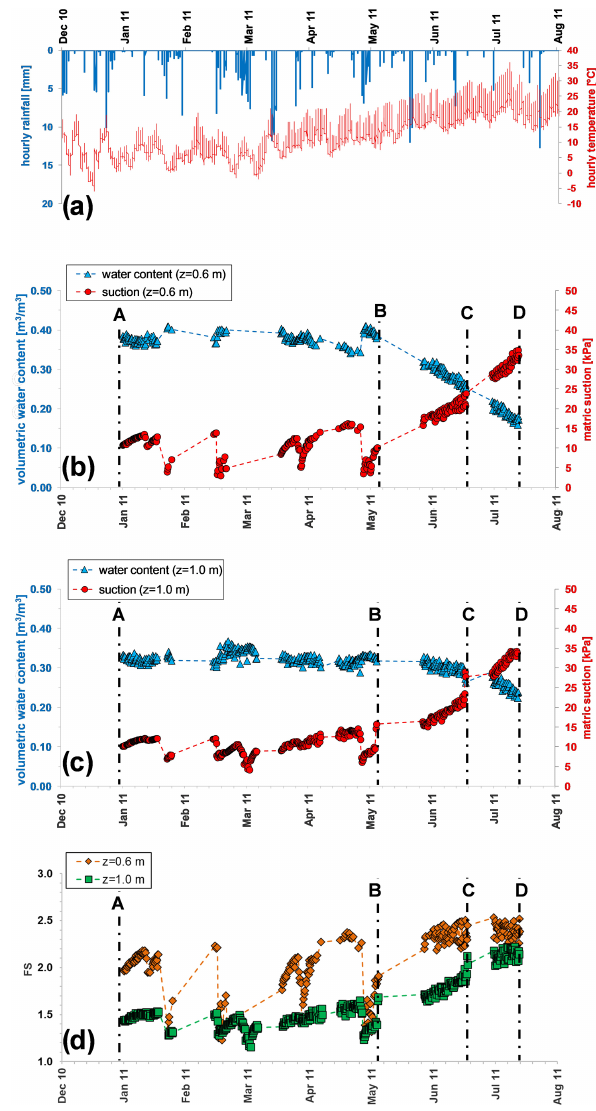
Figure 9. Hourly weather data (a) , matric suction and volumet- ric water content monitored from January to July 2011 at depth z = 0.60m (b) and z = 1.00 (c) , and factor of safety, FS (d) , calcu- lated by Eq. (2), provided by the simplified infinite slope model, and assuming a homogeneous deposit with slope angle α = 40 ◦ , unit weight γ = 14kNm − 3 , cohesion c (cid:48) = 0, friction angle ϕ (cid:48) = 38 ◦ , θ s = 0 . 75m 3 m − 3 , and θ r =